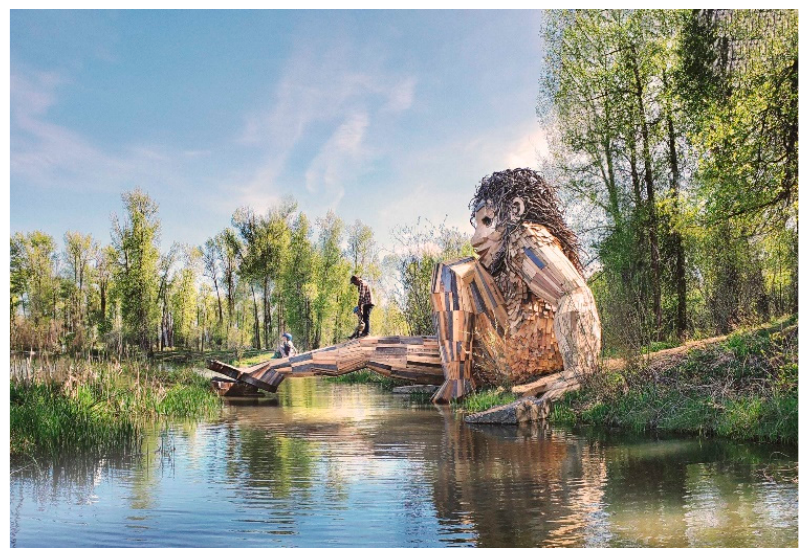
Figure 1. Thomas Dambo, Mama Mimi , Rendevouz Park, Jackson Hole, USA. Source: https://thomasdambo.com/works/mamamimi (accessed on 30 August 22). Courtesy Thomas Dambo.